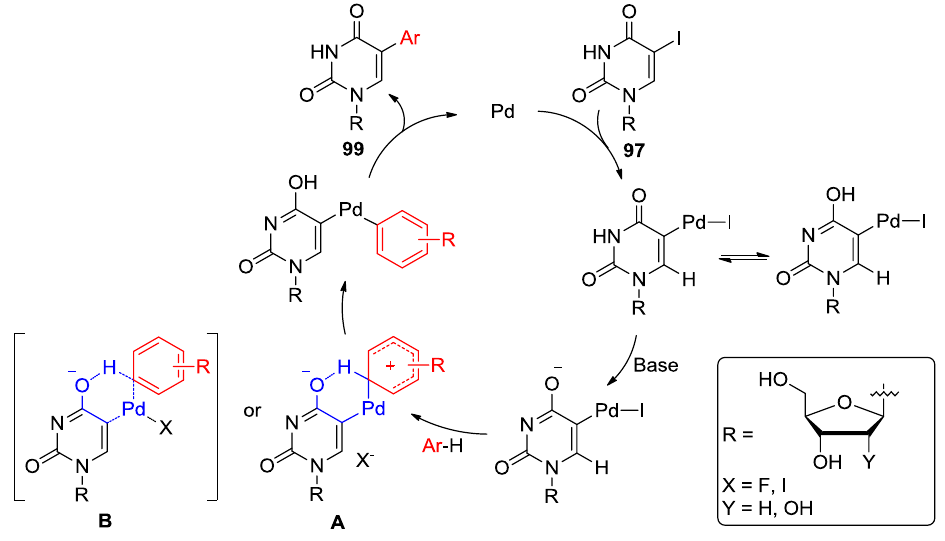
Figure 3. The plausible mechanism for the Pd-catalyzed arylation of 5-iodouridine with